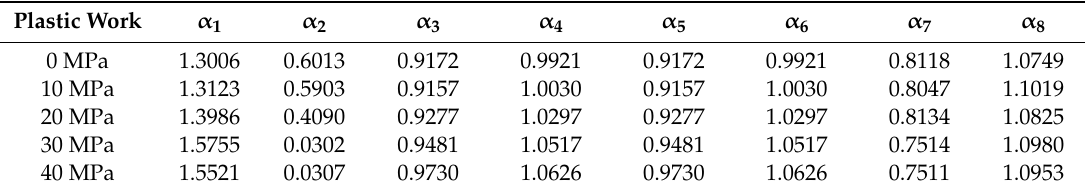
Table 7. Calibrated parameters for the yield function of the niobium sheet for every 10 MPa increments of the plastic work ( m = 6).